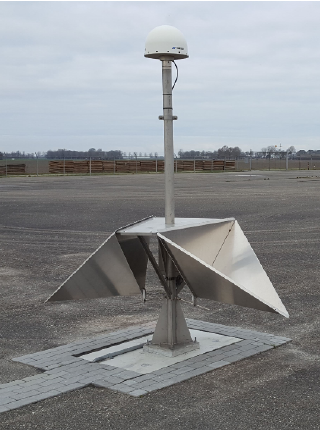
Figure 1. IGRS; design by Delft University of Technology.